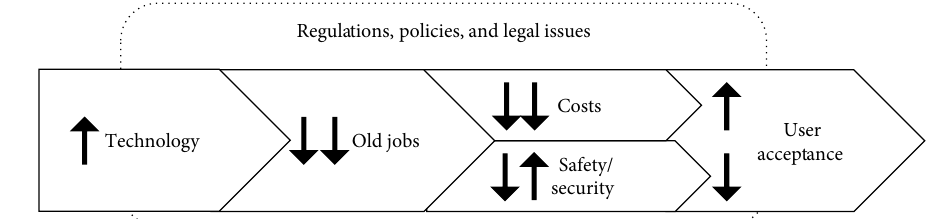
Figure 5: Relationships between the